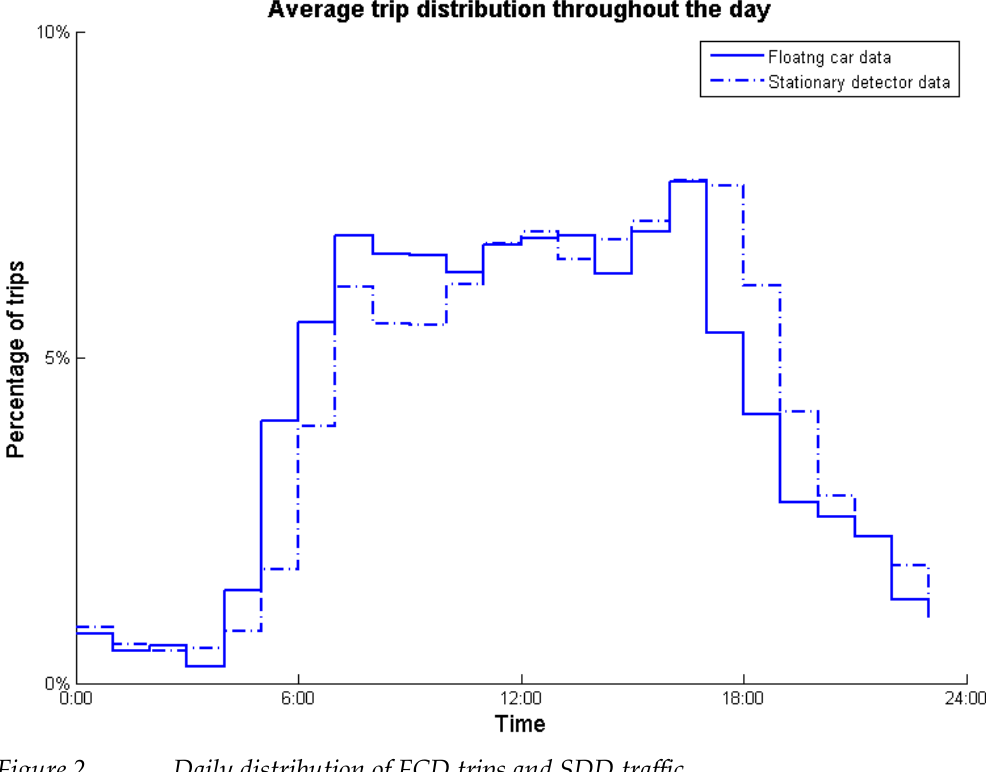
Figure 2. Daily distribution of FCD trips and SDD traffic